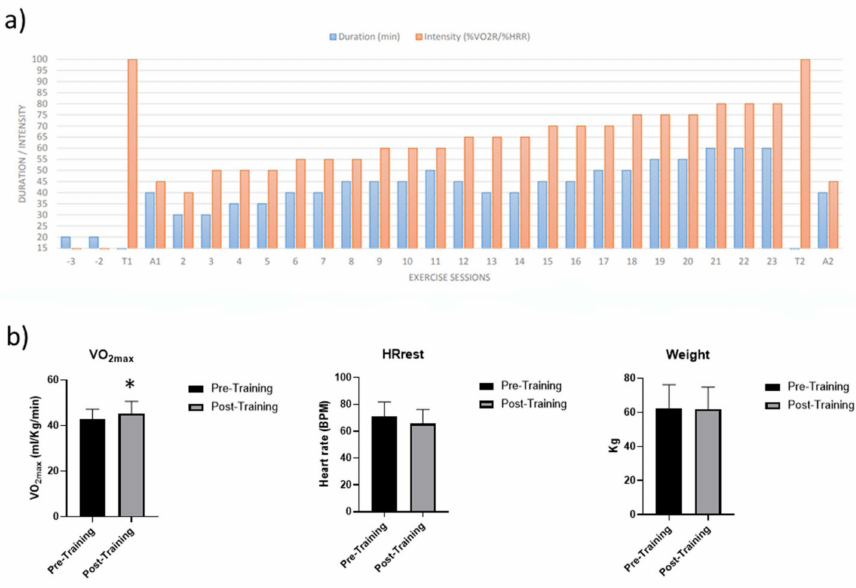
Figure 1. ( a ) Schematic representation of AT protocol. ( b ) VO 2max values, Heart rate at rest (HRrest) and body weight variations following aerobic training. Values are mean ± SD. * significant difference Pre- vs. Post-Training ( p < 0.05, paired t